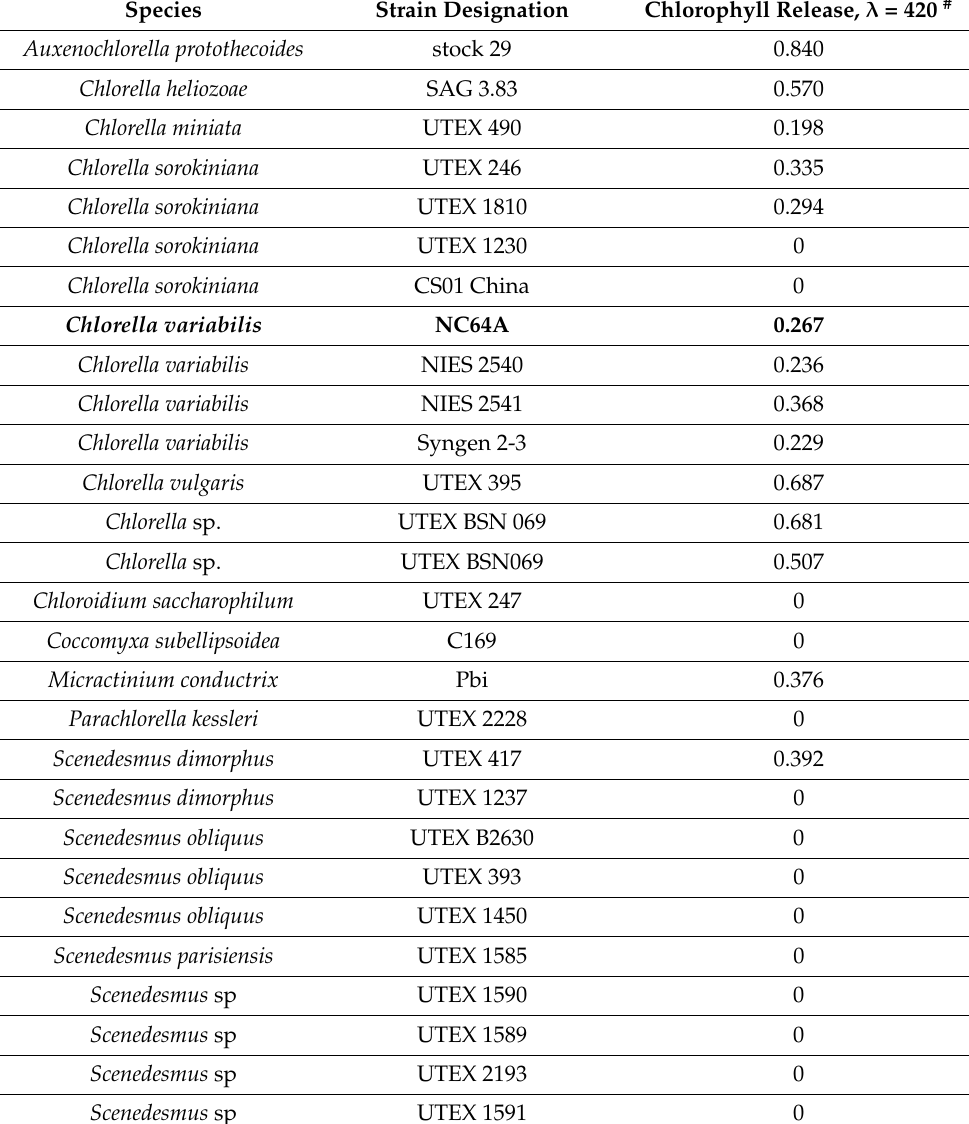
Table 1. Sensitivity of different green algae to recombinant A561L D4 overexpressed